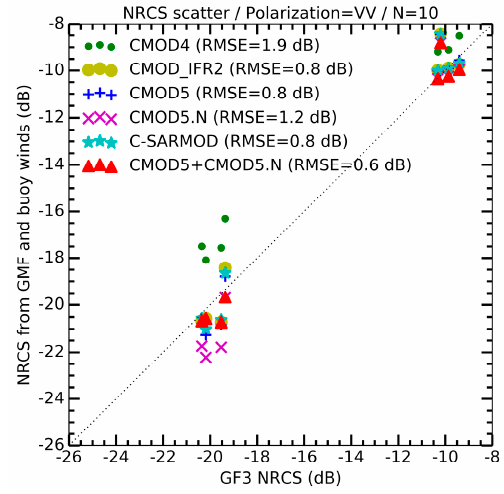
Figure 7. Scatterplots of GF-3 NRCS of VV polarization against NRCS from GMFs using collocated NDBC buoy winds as inputs.